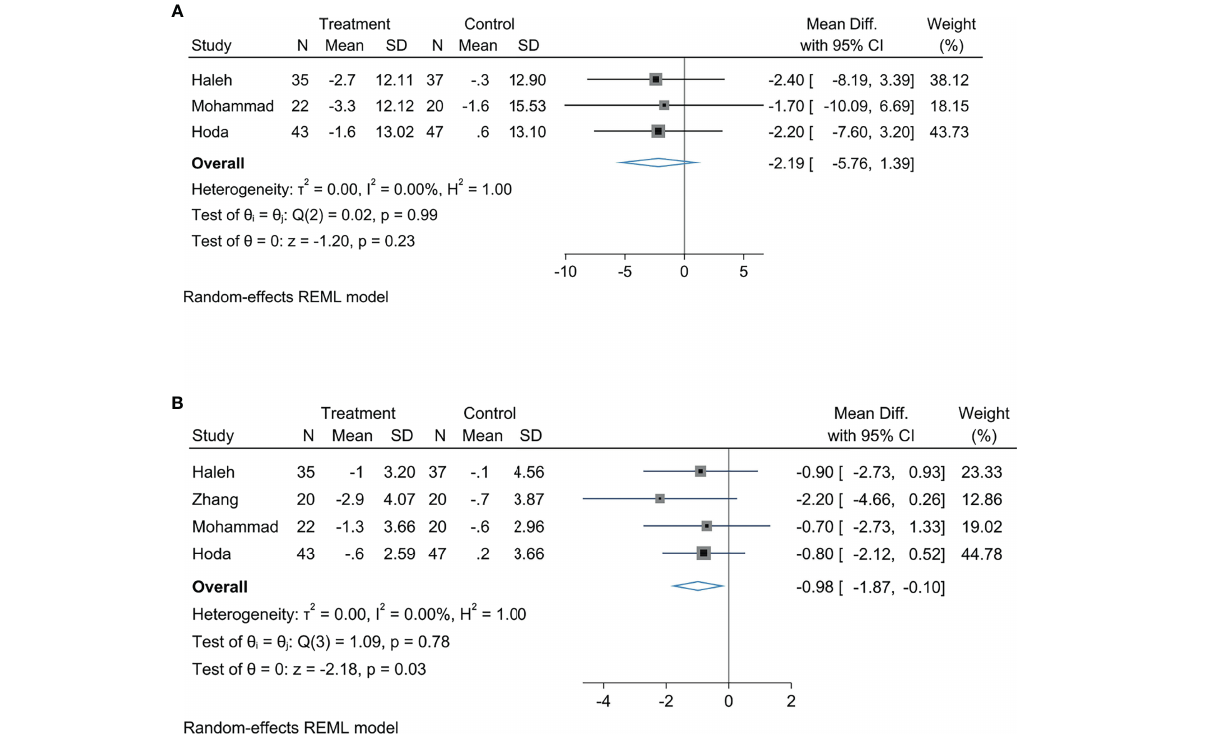
FIGURE 5 | The effect of empagli fl ozin on weight (A) ; the effect of empagli fl ozin on BMI (B)